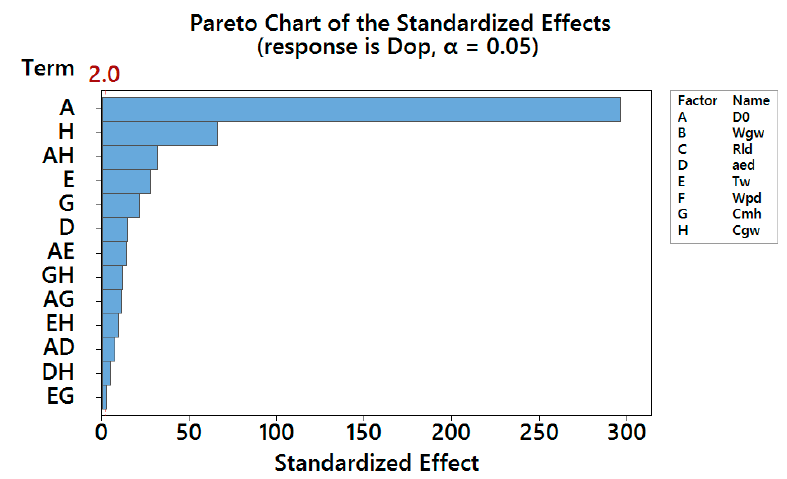
Figure 5. Normal Plot for D e,op .